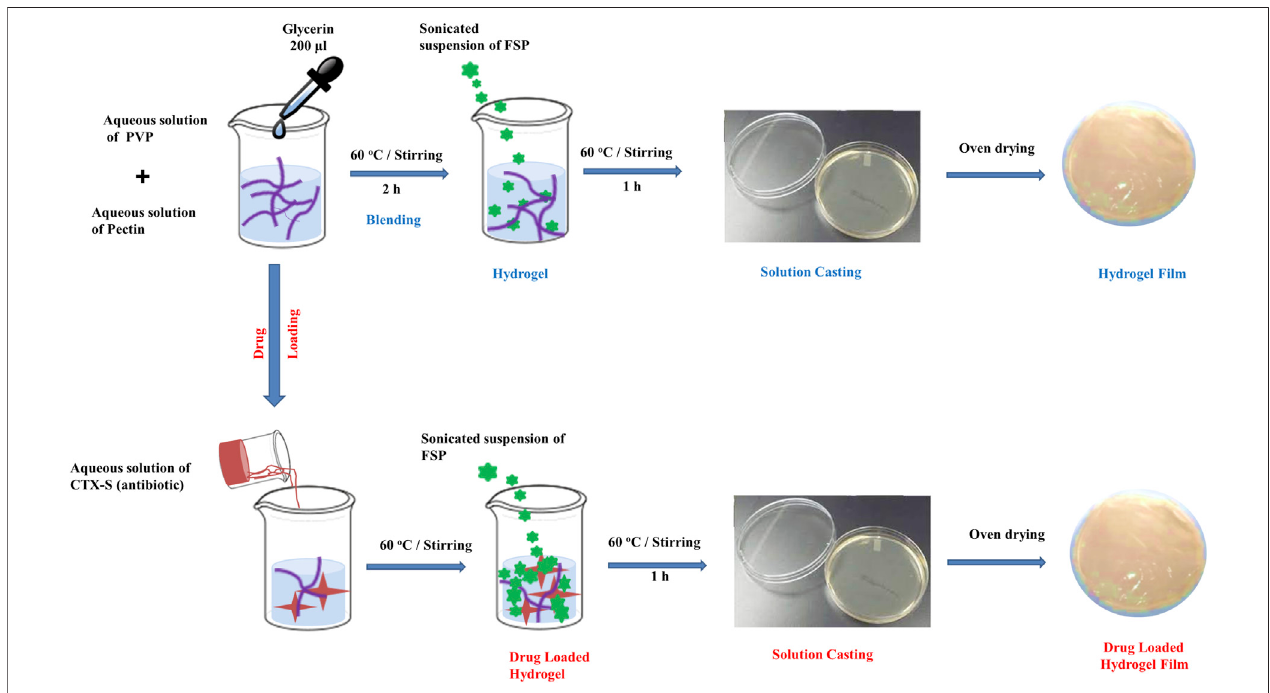
FIGURE 10 | Fabrication of hydrogel fi lms